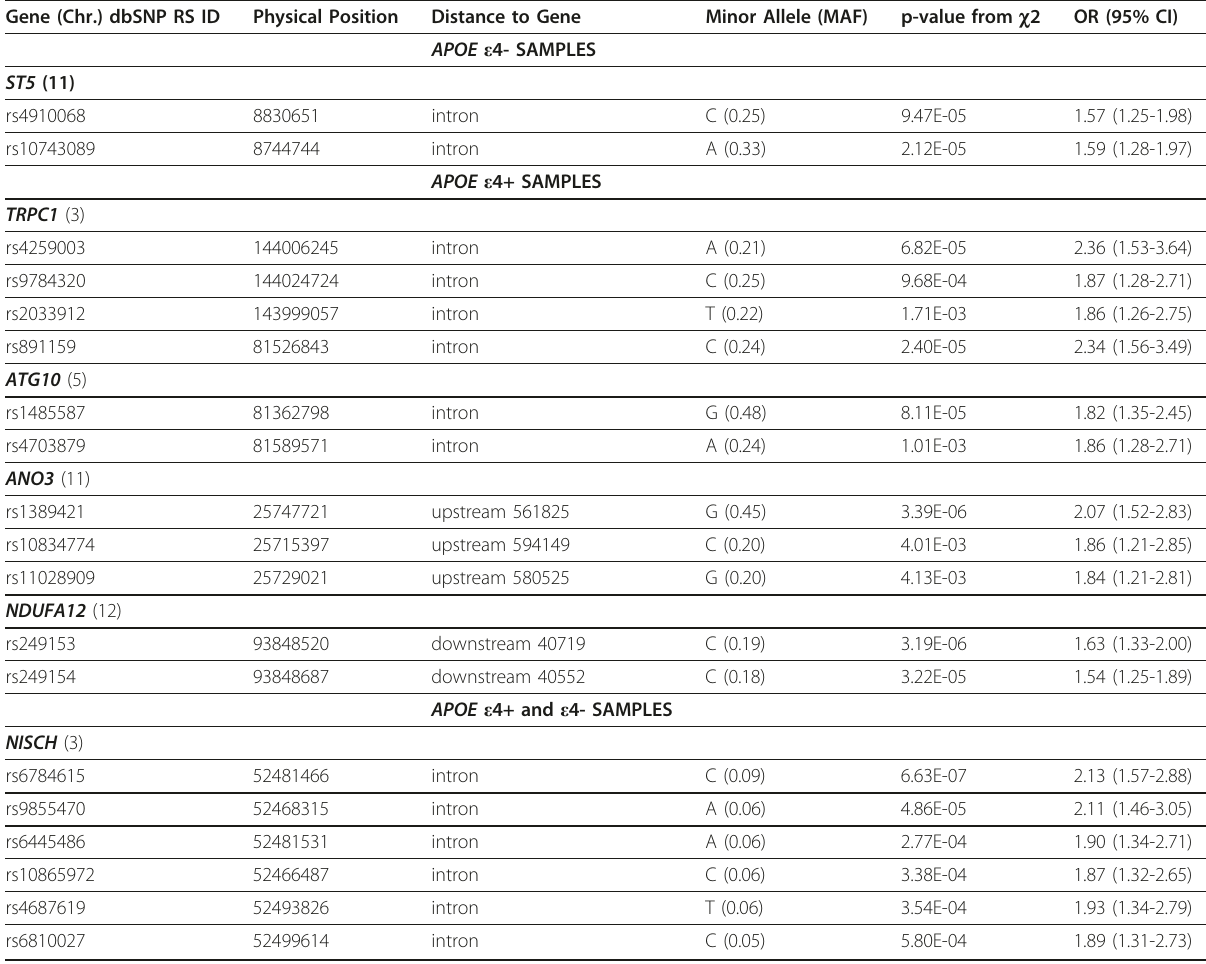
Table 3 CMH top scoring SNPs in LD, approach II. Gene (Chr.) dbSNP RS